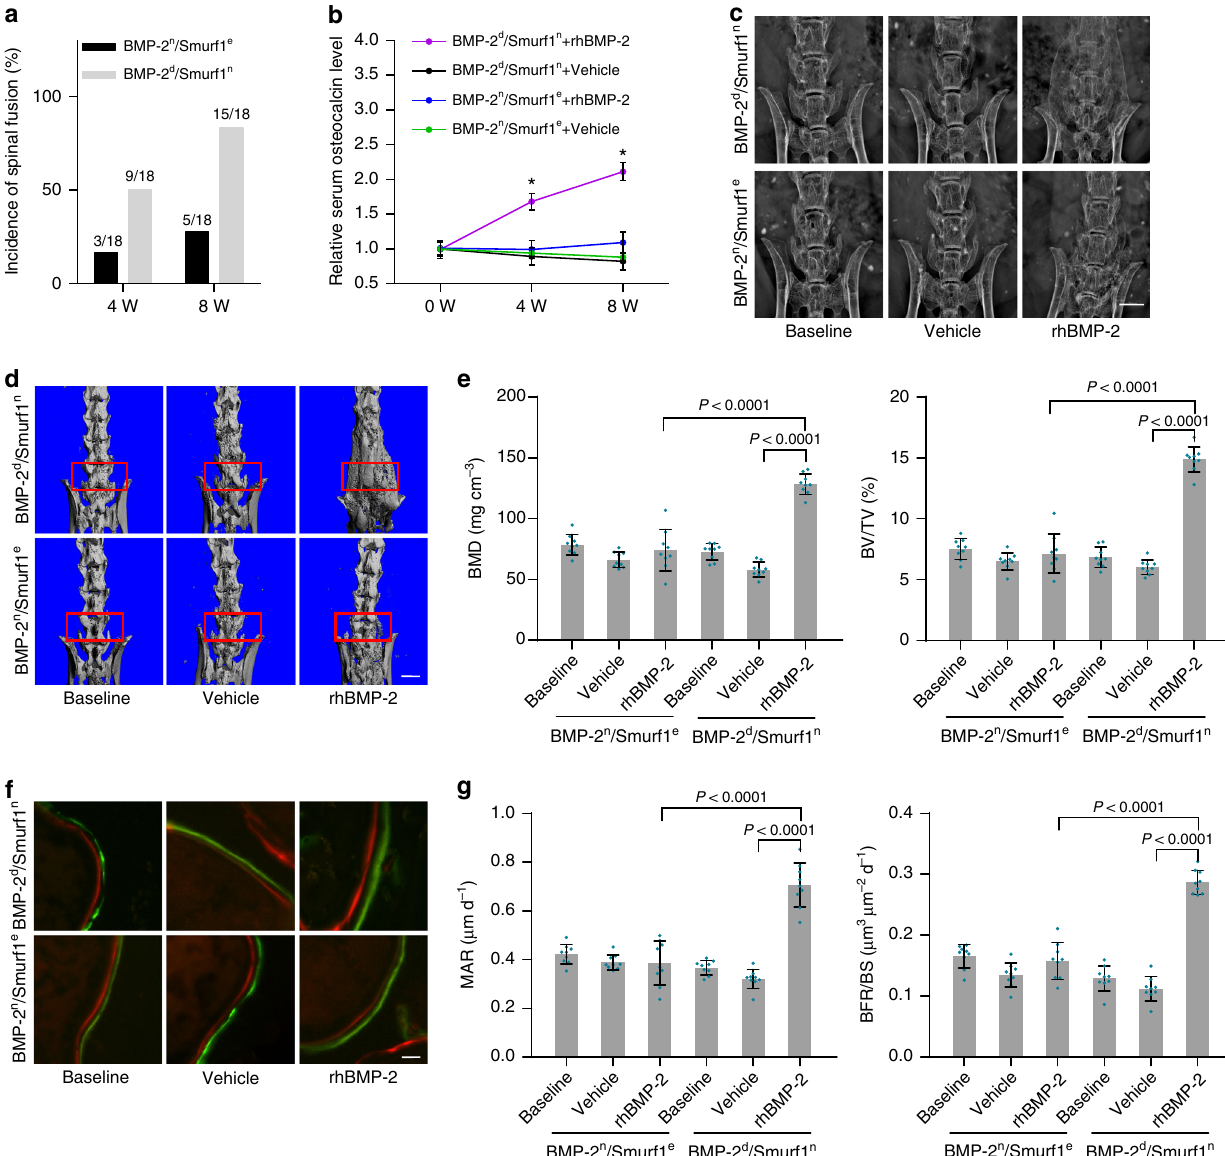
Fig. 3 Local rhBMP-2 response in mouse BMP-2 n /Smurf1 e and BMP-2 d /Smurf1 n subgroups. a Manual assessment of spinal fusion incidence in BMP-2 n / Smurf1 e and BMP-2 d /Smurf1 n subgroups of 15-month-old osteoporotic mice (OVX at 6 months old) with local administration of rhBMP-2 (10 μ g per piece of ACS bilaterally, n = 18 per group). Fisher ’ s exact test was performed ( P = 0.002 for BMP-2 d /Smurf1 n versus BMP-2 n /Smurf1 e at 8 W). b Relative serum osteocalcin level in BMP-2 n /Smurf1 e and BMP-2 d /Smurf1 n subgroups during local administration of rhBMP-2 or vehicle (PBS). The level of serum osteocalcin in BMP-2 n /Smurf1 e and BMP-2 d /Smurf1 n subgroups at 4 weeks (4 W) and 8 weeks (8 W) were normalized to their respective vehicle baseline at 0 week (0 W). * P < 0.0001 for BMP-2 d /Smurf1 n + rhBMP-2 versus BMP-2 n /Smurf1 e + rhBMP-2 at 4 W and 8 W. c Radiographic analysis of spinal fusion in L4-L6 vertebrae by X-ray. Scale bars, 3.0 mm. d Representative images showing intertransverse fusion bridge in spinal fusion sites by microCT reconstruction. Scale bars, 2.5 mm. e microCT measurements for BMD and BV/TV in spinal fusion sites (indicated by red rectangle). f Representative images showing bone formation in spinal fusion sites assessed by xylenol (red) and calcein (green) labeling. Scale bars, 10 μ m. g Analysis of dynamic bone histomorphometric parameters (MAR and BFR/BS) in spinal fusion sites. n = 9 per group. Data are mean ± s.d. followed by one-way ANOVA with a